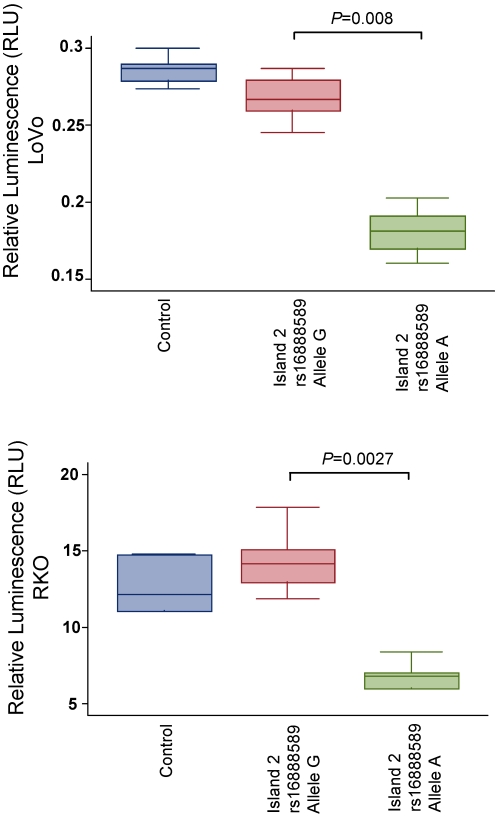
Reporter gene activity for the island 2 construct incorporating rs16888589.Luciferase reporter assays demonstrating repressor activity in LoVo and RKO CRC cell lines.